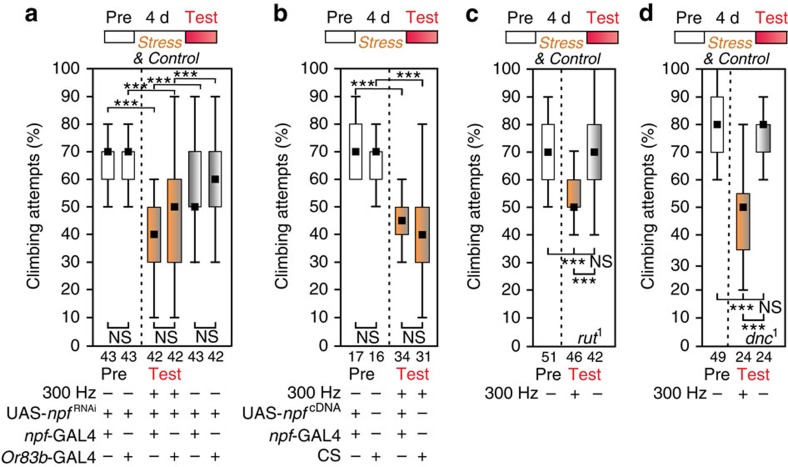
Depression-like state establishes independent of the Neuropeptide-F (NPF) and the cAMP-pathway.(a) Knockdown of npf in its endogenous pattern by npf-GAL4 (ref. 50) driving UAS-npfRNAi can neither prevent nor reinforce the depression-like state whereas sham-treated flies stay active. As a negative control UAS-npfRNAi has been driven in olfactory receptor neurons via Or83b-GAL4. (b) Overexpression of NPF by driving npf-cDNA in its endogenous pattern via npf-GAL4>UAS-npfcDNA cannot either prevent a depression-like state after 4 days of vibration treatment. Wild-type CS for comparison. (c,d) Learning mutants that cannot be conditioned by sexual rejection and deprivation rut1 (rutabaga encodes for an adenylyl cyclase) and dnc1 (dunce encodes for a phosphodiesterase) develop the depression-like state after 4 days of vibration treatment. Sham-treatment for control. Black squares, medians; boxes, 25 and 75% quartiles; whiskers, 10 and 90% quantiles; numbers of animals are indicated below each box; NS, not significant; ***, P<0.001; Kruskal–Wallis test.